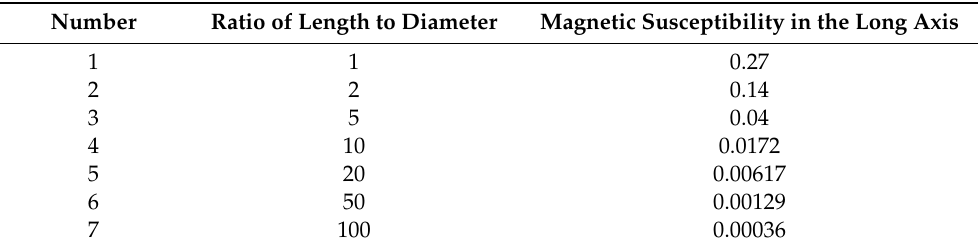
Table 1. Demagnetizing factor for soft magnetic materials with di ff erent length-diameter ratios.